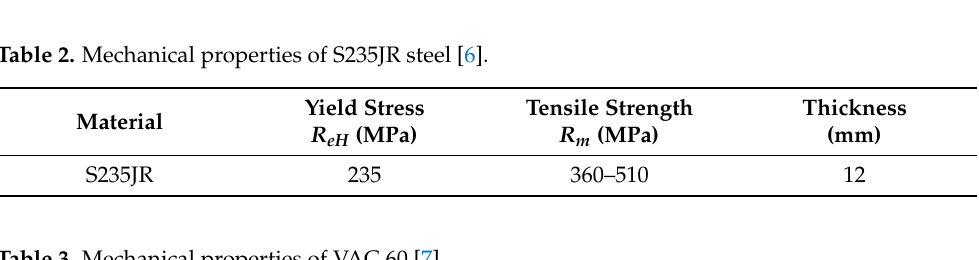
Table 3. Mechanical properties of VAC 60 [7].